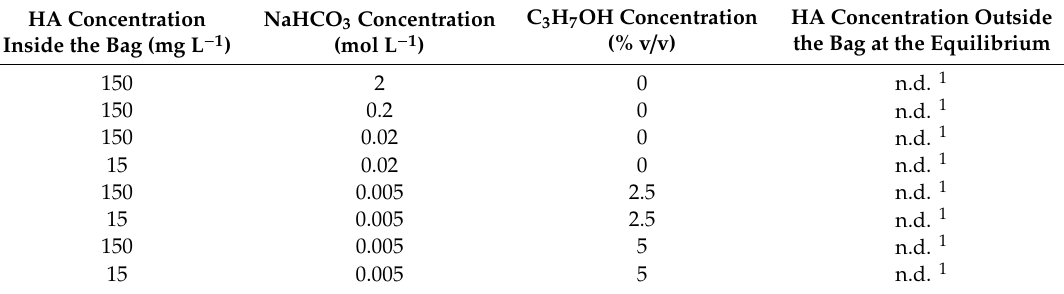
Table 1. Equilibrium conditions of membrane dialysis